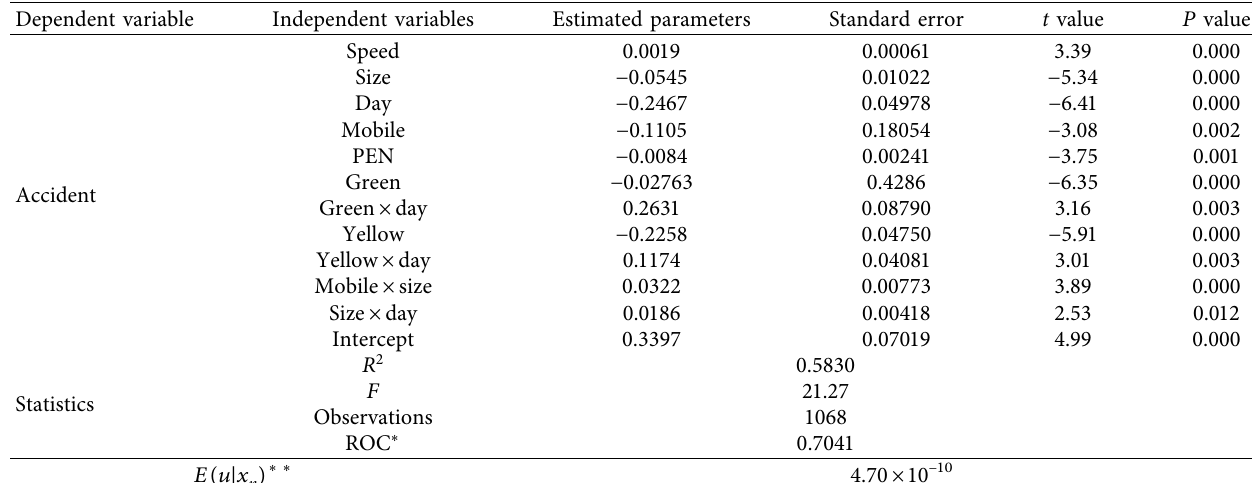
Table 3: LPM model of accident likelihood in relation to hazard